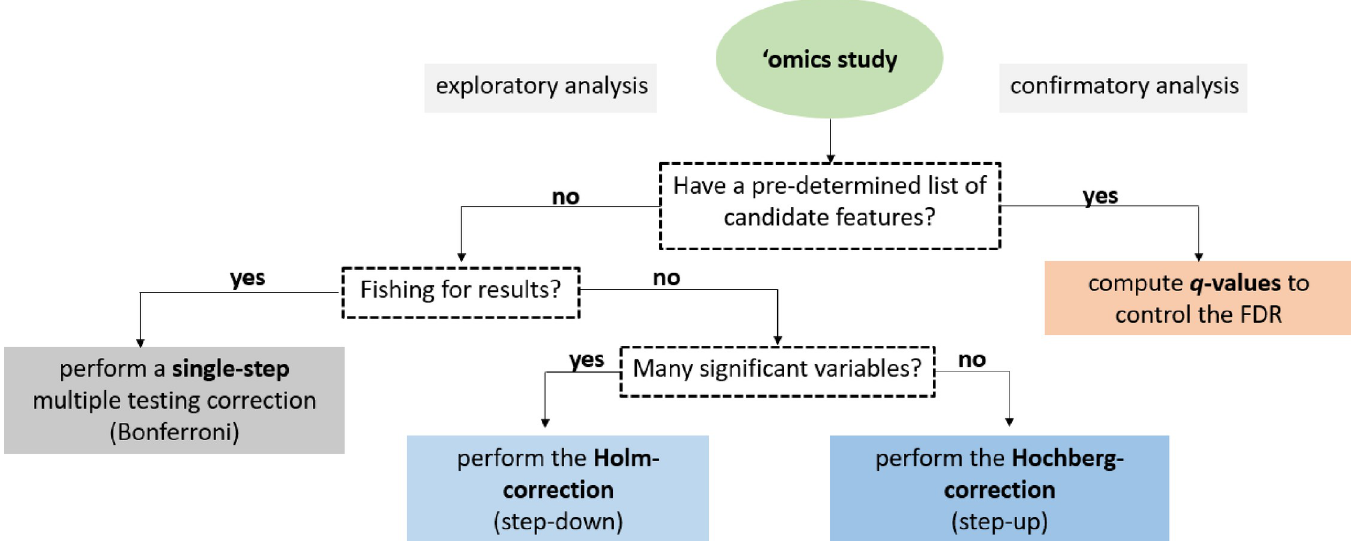
Fig 1. A decision tree to facilitate the selection of suitable methods for multiple testing correction. The initial decision relies upon the statistical analysis’s exploratory or confirmatory nature, while subsequent steps narrow down the list of appropriate methods. In some cases, though, studies are based on a mixture of exploratory or confirmatory